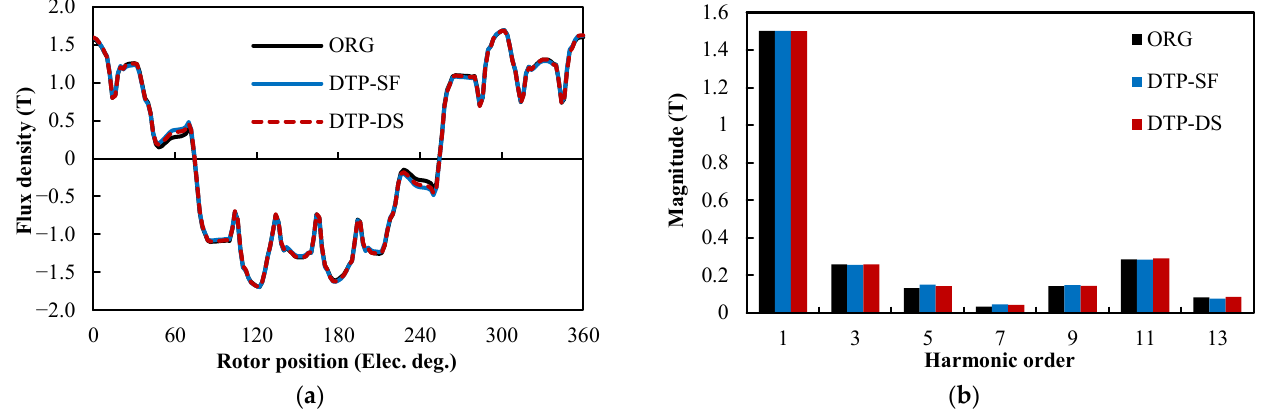
Figure 21. Air-gap flux density distributions of different winding configurations at I A = 236 Apk, β = 0°: ( a ) waveforms; ( b ) spectra.